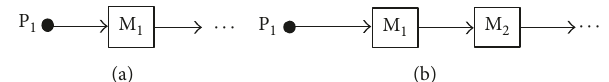
Figure 3: MPC consisting of (a) one machine and one part and (b) two machines and one part.